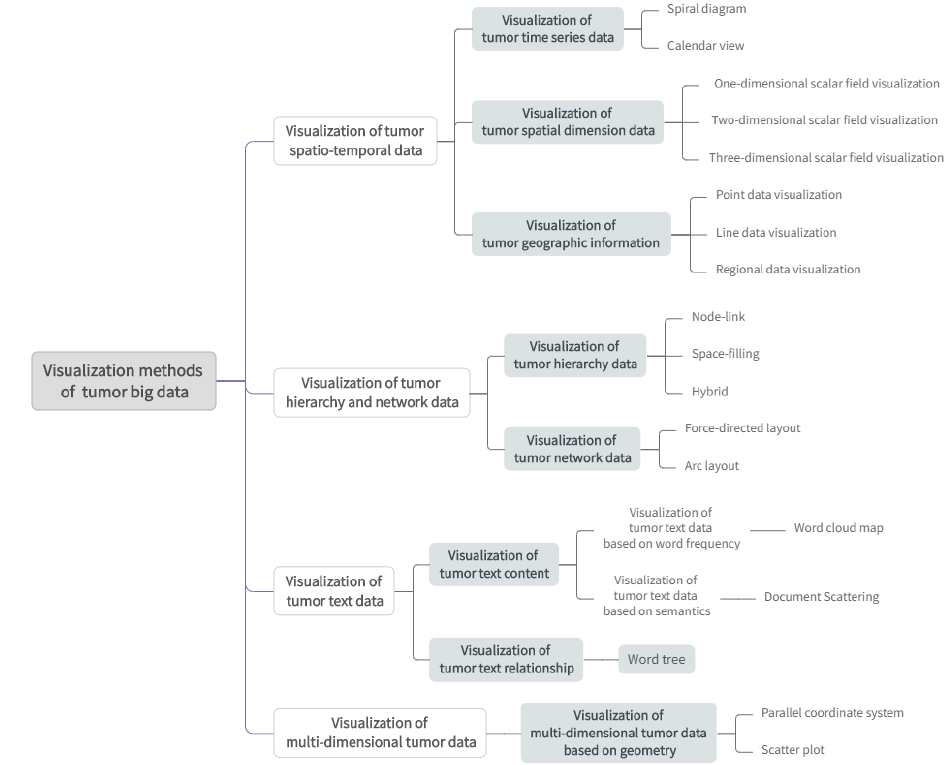
Figure 3. Mind map of tumor big data visualization